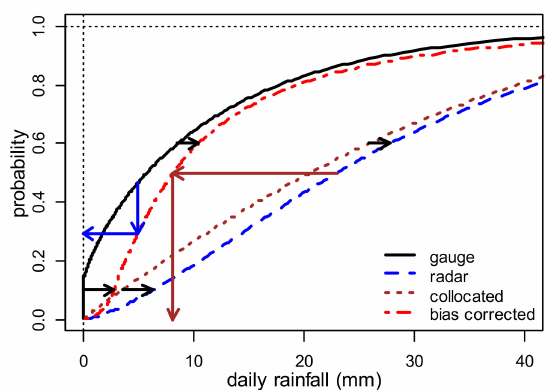
Figure 2. Bias correction scheme: black arrows show the errors in the collocated rainfall amount that is added to the gauged amount to obtain the “true” distribution (red curve); blue arrows indicate the correction of the probability of the gauge rainfall amount; brown arrows show the correction applied to the radar rainfall